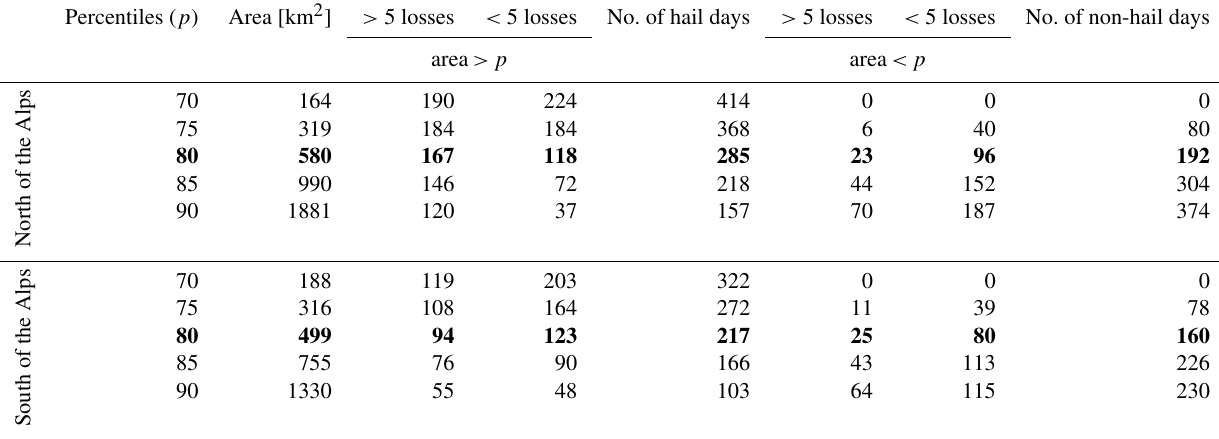
Table B1. Number of days > 200km 2 per area percentile ( p ) and number of car insurance loss reports (losses). The 80th percentiles (bold lines) were chosen as thresholds to delimit hail days from non-hail